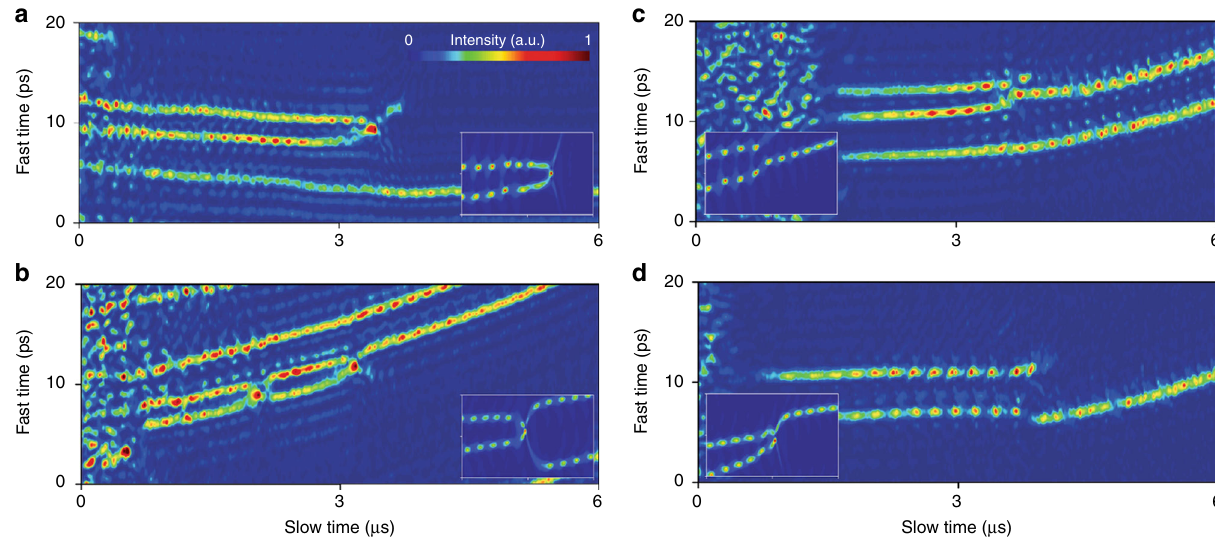
Fig. 2 Measurements of non-repetitive soliton events. a Two solitons collide and annihilate. A wave splash appears in the collision. b Two solitons survive a collision, but collide again and one soliton is annihilated. c Two solitons collide and merge into a single soliton. d A soliton hops in location when another soliton is annihilated. The measurement frame rate is 50 MHz in all panels. Inset panels show similar collision events from numerical simulation, including the appearance of the wave splash (inset in a )